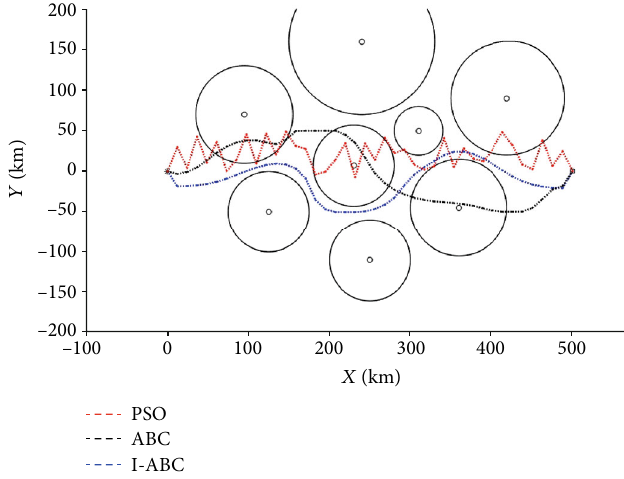
Figure 18: The comparative path planning results.